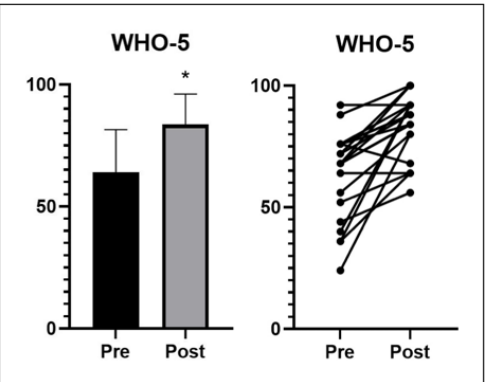
Figure 3. World Health Organization’s (WHO) -5 questionnaire results pre- and post-intervention (n = 23). Means ± standard deviation (SD). * Significantly different from pre-intervention.